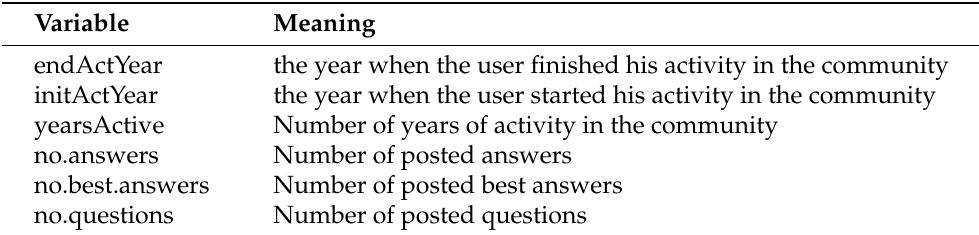
Table A2. Descriptions of variables